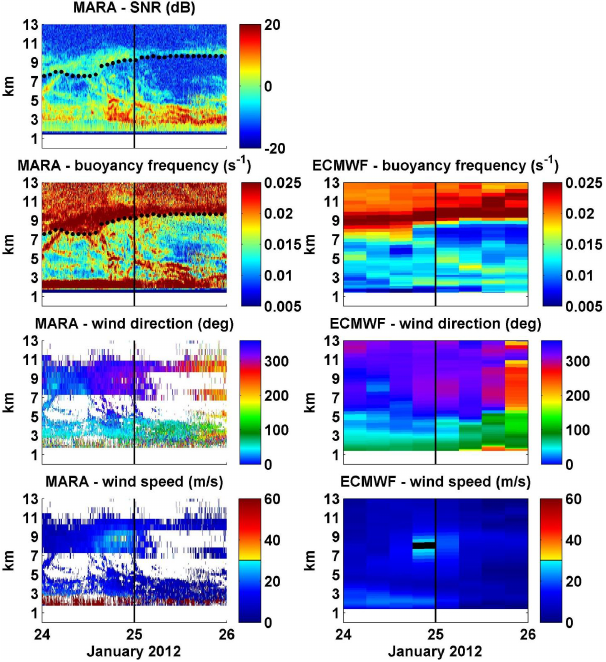
Fig. 3. Observation of a tropopause folding event on 24 and 25 Jan- uary 2012 at Troll station, Antarctica, by MARA radar (left side) and as seen by ECMWF-constructed time profiles (right side). The indicated height is height above mean sea level. Black dots repre- sent the radar tropopause height. Vertical black line represents the time (25 January 2012, 00:00UTC) corresponding to the vertical cross section and tropopause map in Fig. 2.